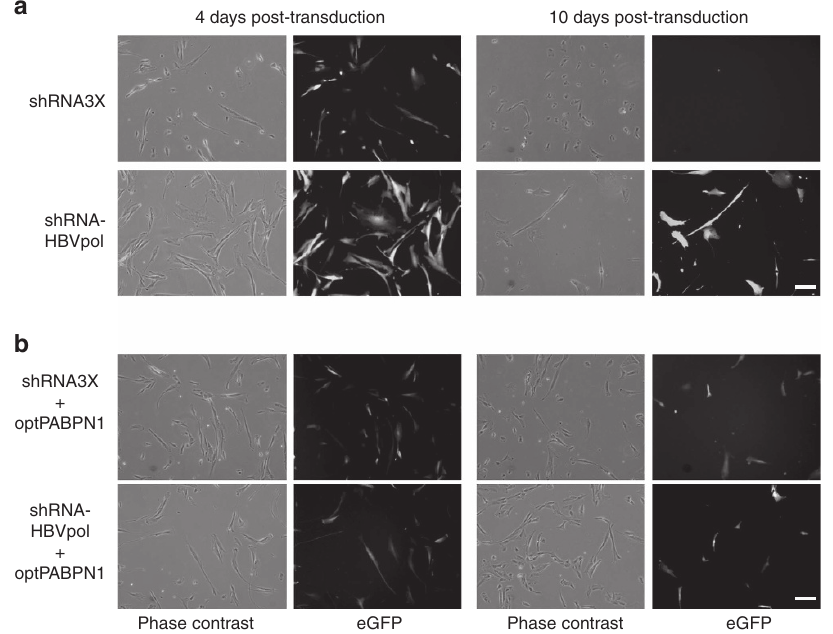
Figure 6 | PABPN1 inhibition in human OPMD myoblasts induces cell death that can be prevented by optPABPN1 co-expression. ( a , b ) Primary OPMD myoblast cells were transduced with shRNA3X tricistronic cassette, shRNA-HBVpol, shRNA3X-optPABPN1 or shRNA HBVpol-optPABPN1 LV vectors. GFP observed 4 and 10 days post transduction demonstrates that no GFP þ cells survived on the condition transduced with shRNA3X. However, co-transduction with shRNA-HBVpol-optPABPN1 prevented cell death. Bar, 100 m viral vectors we used in this study are in a standard range for intramuscular purpose in murine models, where a single injection is performed to transduce the whole TA muscle. In the context of